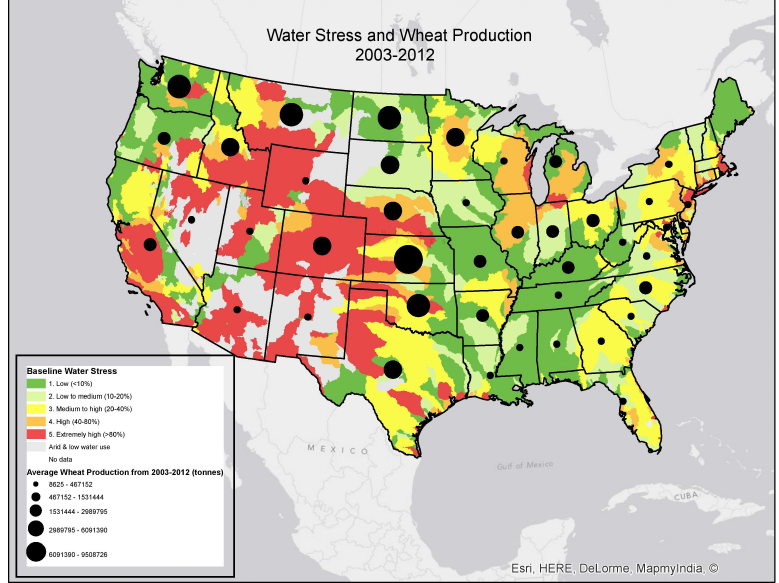
Figure 2. Water Stress and Wheat Production Source: U.S. Geological Survey National Water Information System, https://waterdata.usgs.gov/nwis [9].